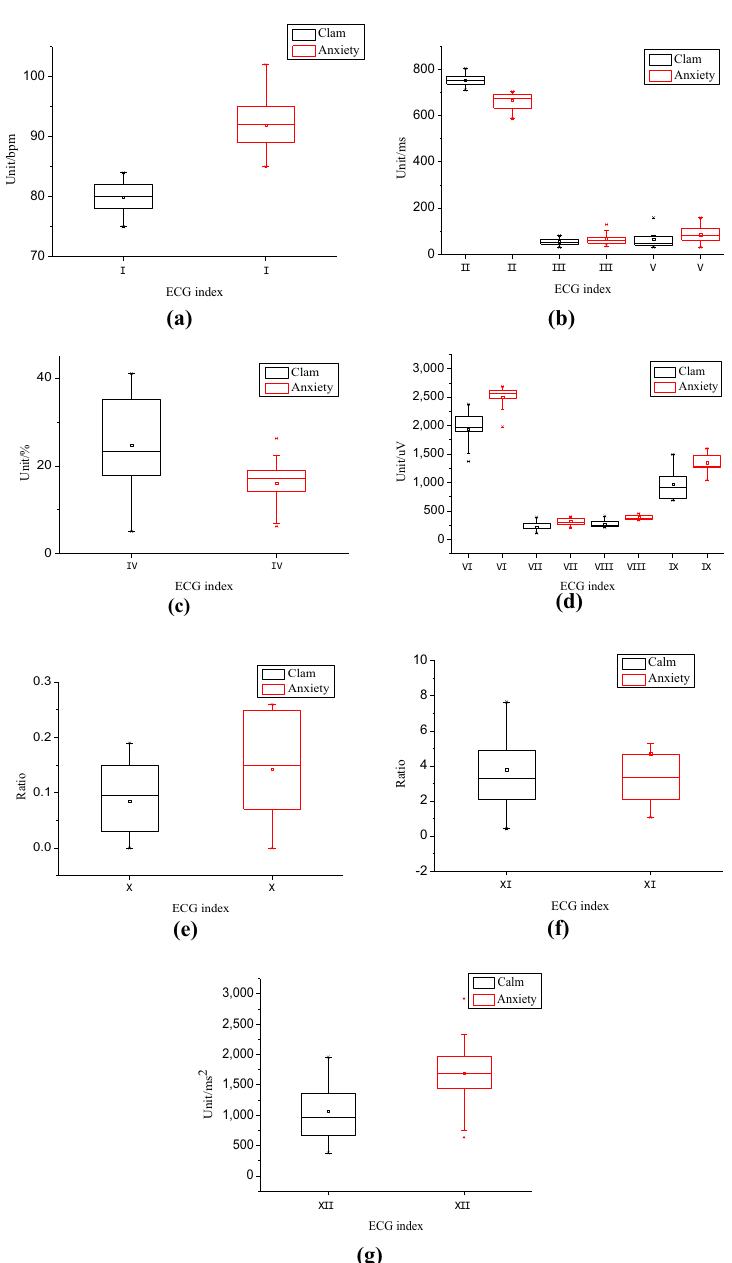
Figure 13 Subjects ’ ECG characteristic indicators in calm and